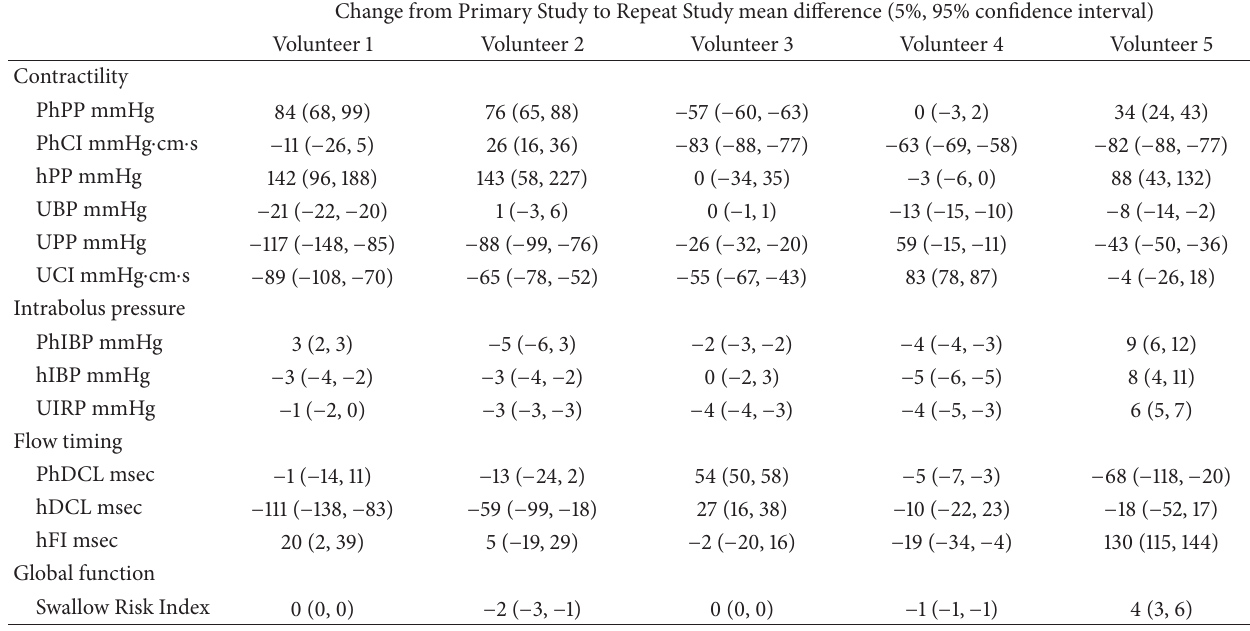
Table 4: Test-retest change in measurements from Primary Study to Repeat Study in swallow function variables. Data are mean difference in the results of the six analysts with 95% confidence intervals of the difference shown in parentheses. Individual data for each study volunteer are shown (based on 1st analysis results only).